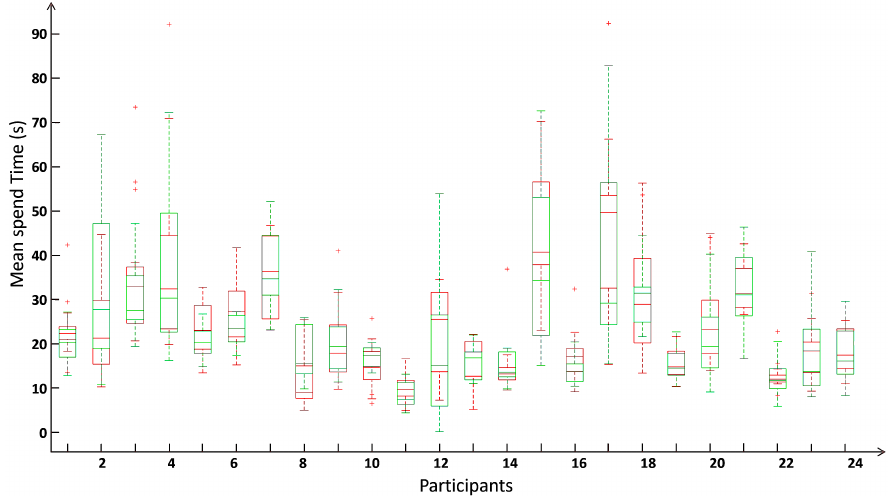
Figure 12. Time spent for consistent and non-consistent evaluations for each